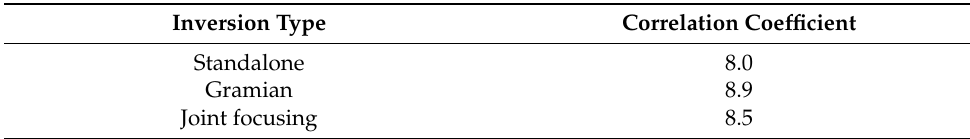
joint Gramian inversion, and joint focusing inversion, respectively.